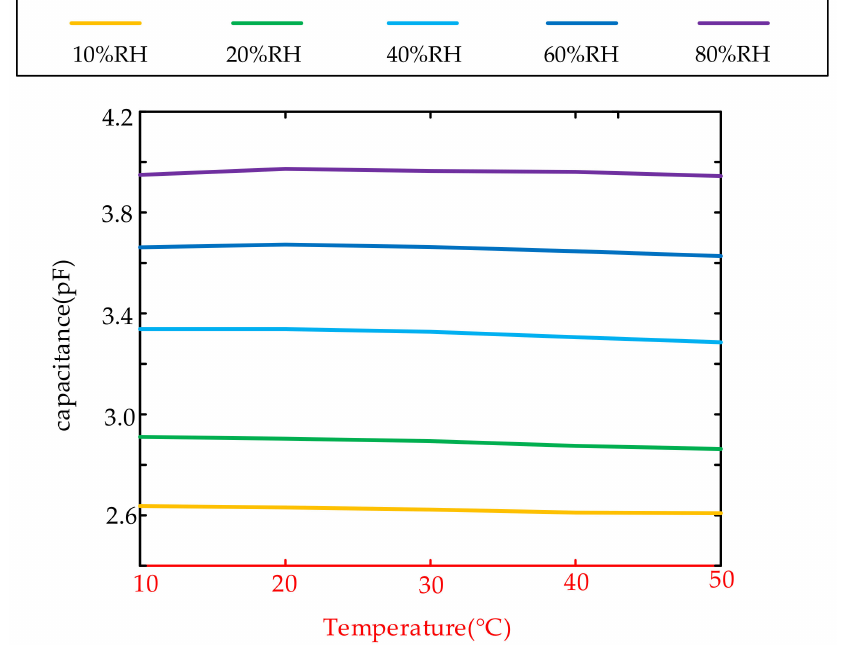
Figure 4. Relationship between Polyimide Humidity Capacitor and Temperature and